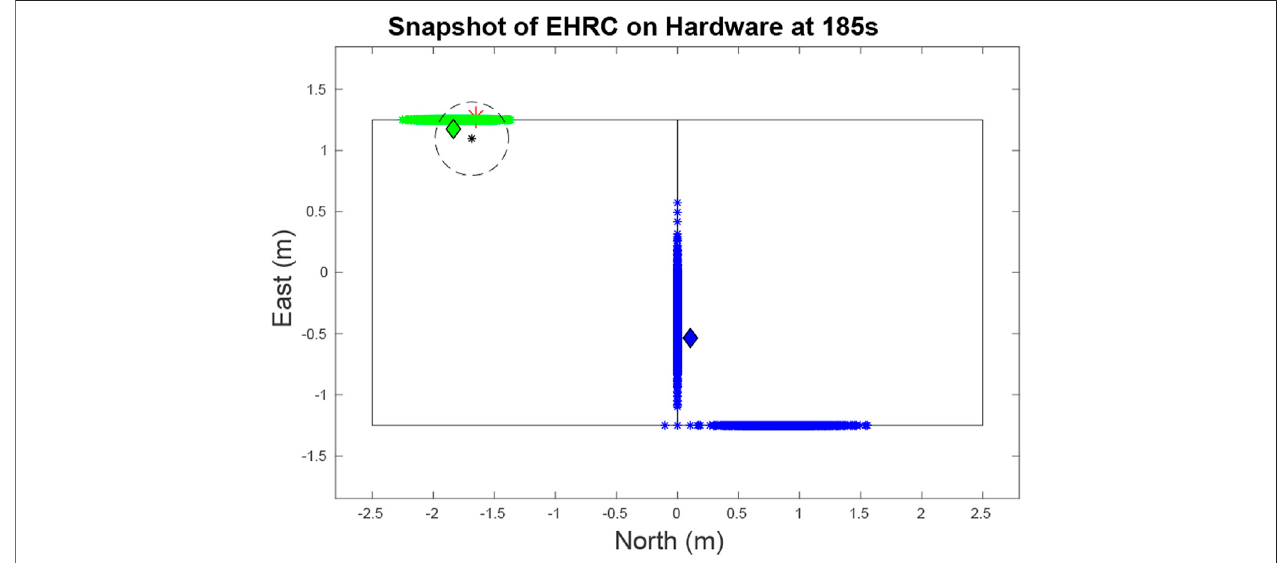
FIGURE12| Snapshotatat 185 softhetargetand UAVstatesduring ahardwaretest. Theredasteriskrepresentsthequadcopter. Thegreenandbluediamonds are the current locations of each of the two vehicles. As can be seen, the green particle cloud is closely aligned with the actual position of its target. And while there are multiple modes for the blue target representing different estimates, the blue target is closely aligned with one of its modes. The black star and circle represents the estimate and error margin of a target sighting, which when funneled through our data association algorithm, performs a positive update on the green target.